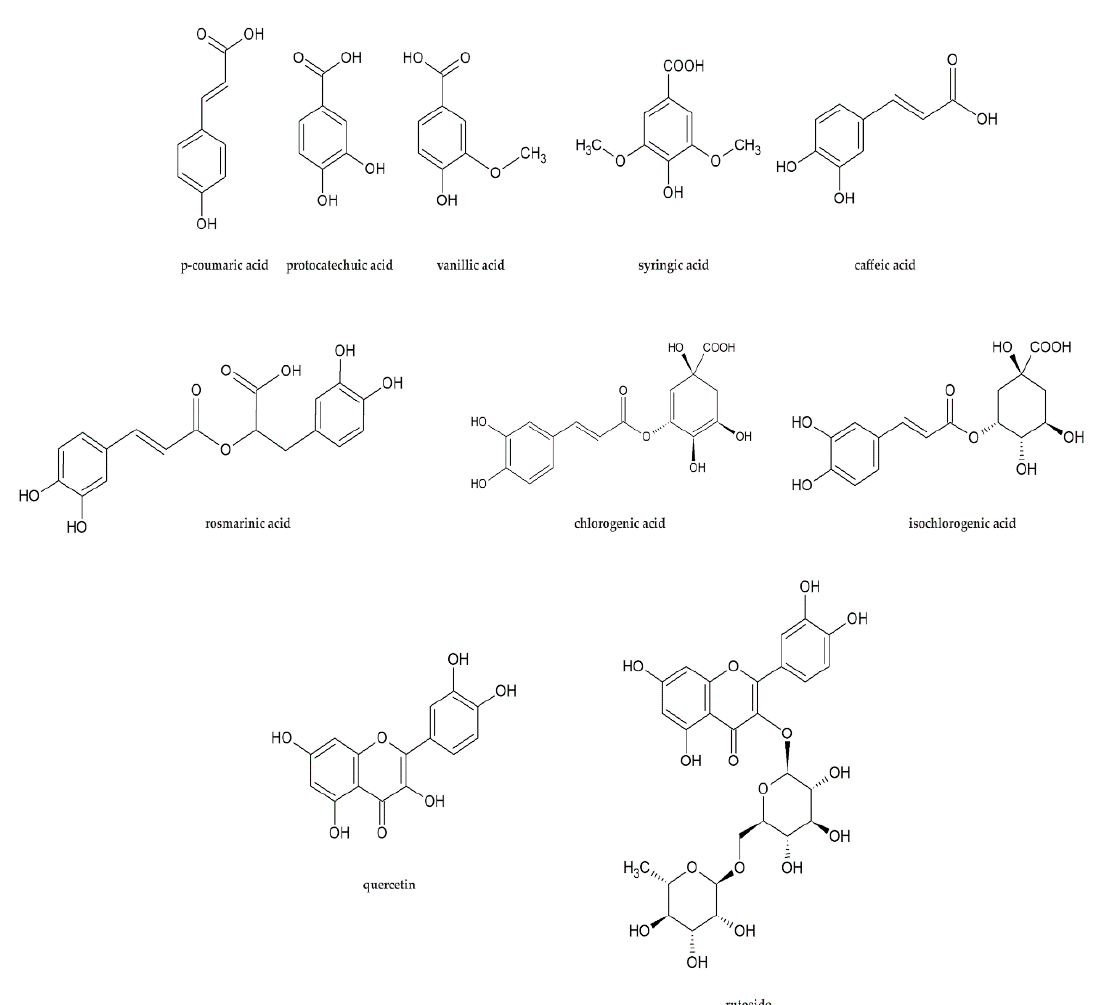
Figure 1. The chemical structures of the identified polyphenols.